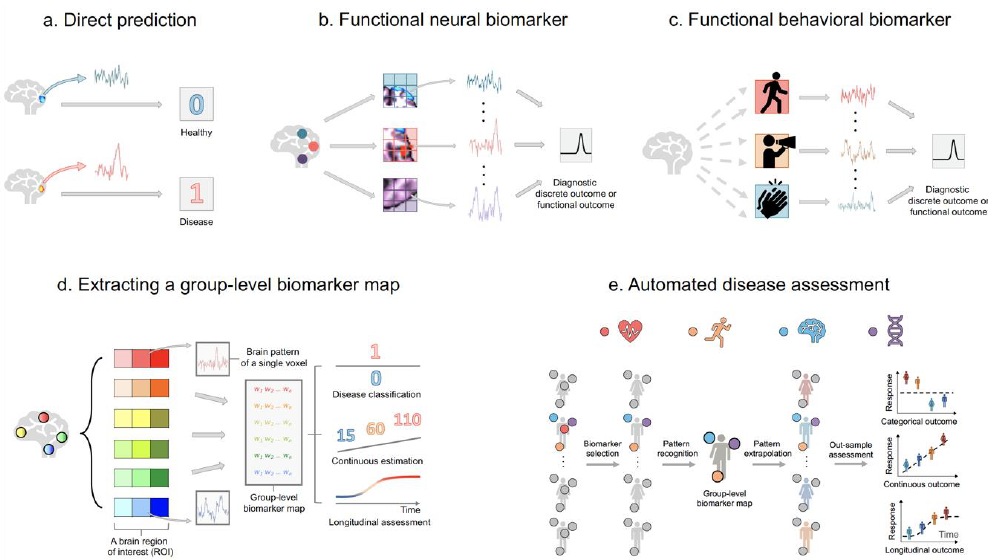
Figure 4. Using predictive models to diagnose disease, estimate disease severity, and assess disease progress. ( a ) A neural biomarker from a specific brain region is directly mapped to a diagnostic clinical outcome. ( b ) The functional neural biomarker framework. By evaluating the spatial pattern across subjects, the framework identifies multiple biomarkers related to diagnostic clinical outcomes. ( c ) The functional behavioural biomarker framework. When brain data is not available, behavioural data (such as physical activity, speech pattern, and hand movement) recorded semi-continuously from wearable computers serve as biomarkers. ( d ) Extracting a predictive map using functional behavioural biomarkers. Each box refers to a voxel; voxels with the same colour but di ff erent hues indicate the same anatomical or functional region. The coloured w 1 , w 2 , ··· w n represent predictive weights